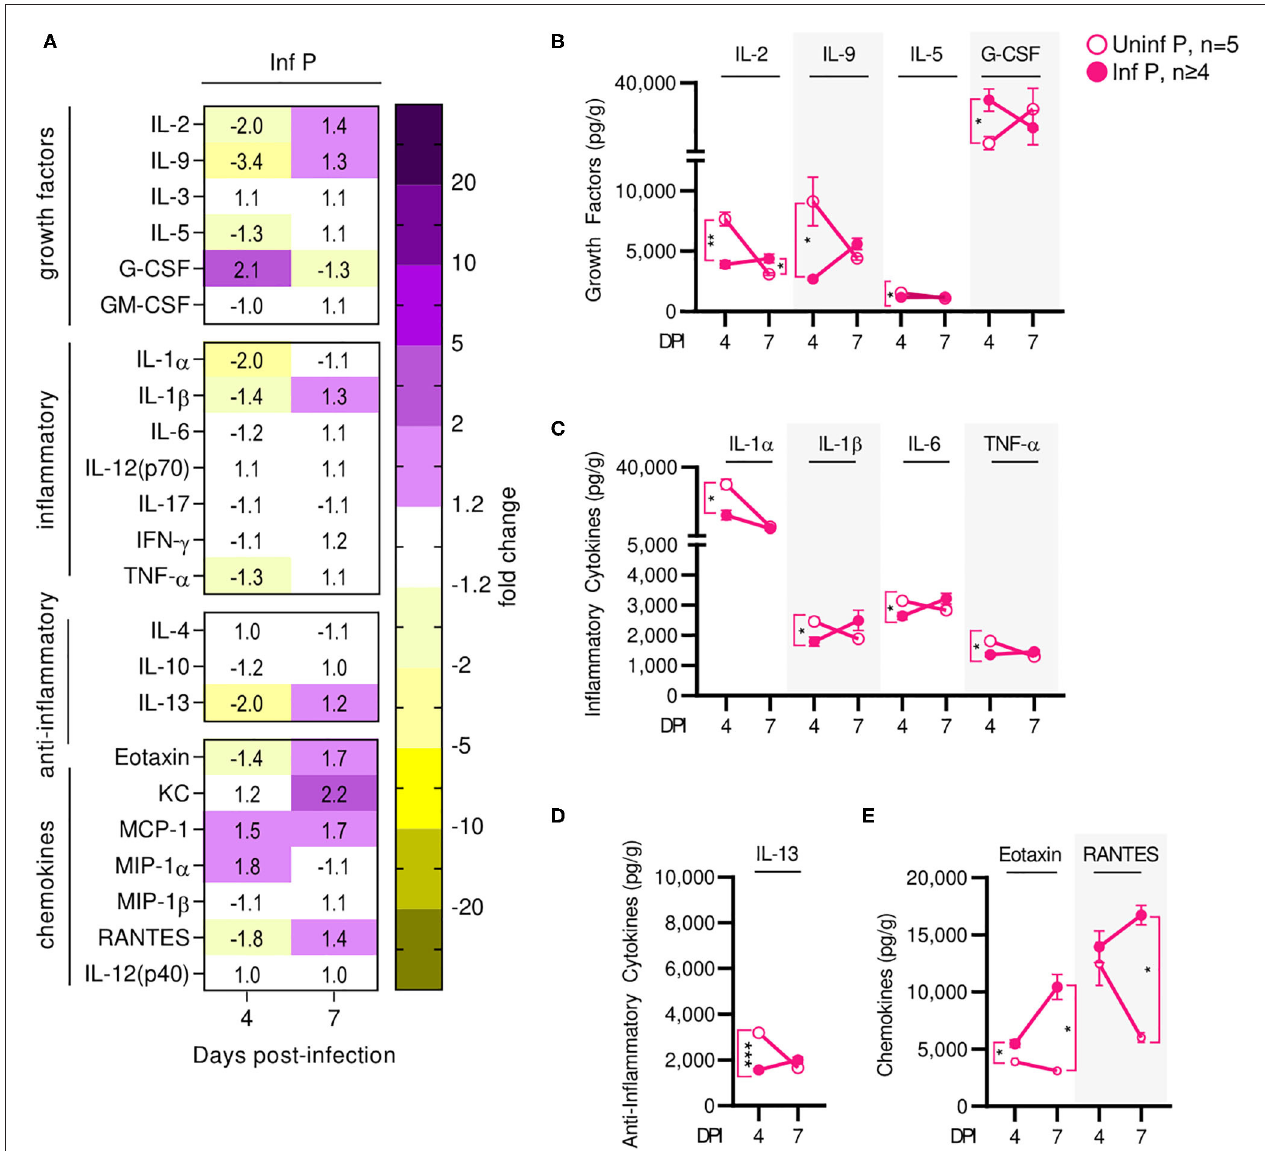
FIGURE 6 | Influenza infection results in an early increase of placental macrophage-secreted T cell stimuli. (A) Protein concentrations from infected placental lysates collected at 4 and 7 DPI were normalized to uninfected controls. Lysates were quantified for growth factor, inflammatory and anti-inflammatory cytokine, and chemokine concentrations. Values within the heat-map denote mean fold change over uninfected controls. Fold change was transformed as follows: if fold change > 1, no transformation; if fold change < 1, –(10 | log10fold change |). Concentrations of growth factors (B) IL-2, IL-9, IL-5, and G-CSF, the inflammatory cytokines (C) IL-1 α , IL-1 β , IL-6, and TNF- α , anti-inflammatory cytokines (D) IL-13, and the chemokines (E) eotaxin and RANTES were quantified at 4 or 7 DPI. Cytokine quantitation was analyzed via Two-way ANOVA and post-hoc multiple T -tests without assuming consistent SD with correction for multiple comparisons by controlling the